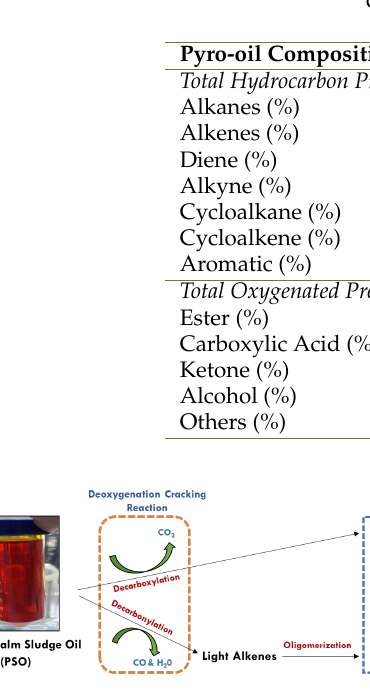
Fig. 4. Deoxygenation reaction in catalytic pyrolysis of SPO using NiO-Malaysian